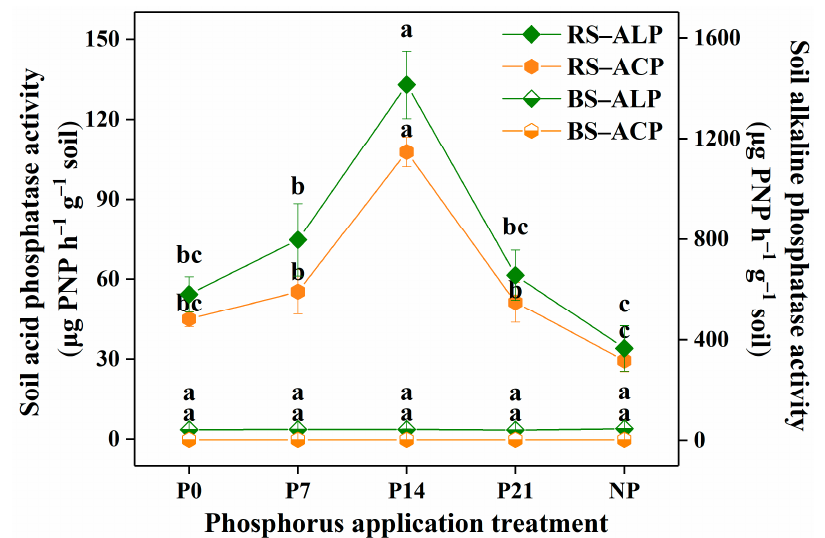
Figure 3. Phosphatase activity (acid phosphatase activity in rhizosphere soil (RS–ACP), alkaline phosphatase activity in rhizosphere soil (RS–ALP), acid phosphatase activity in bulk soil (BS–ACP), and alkaline phosphatase activity in bulk soil (BS–ALP)) as a function of P application time. P0 means P application at planting; P7 means P application at 7 d after planting; P14 means P application at 14 d after planting; P21 means P application at 21 d after planting; and NP means no P application. Different lowercase letters mean significant differences in RS–ACP, RS–ALP, BS–ACP, and BS–ALP among di ff erent treatments at p < 0.05, n = 4.